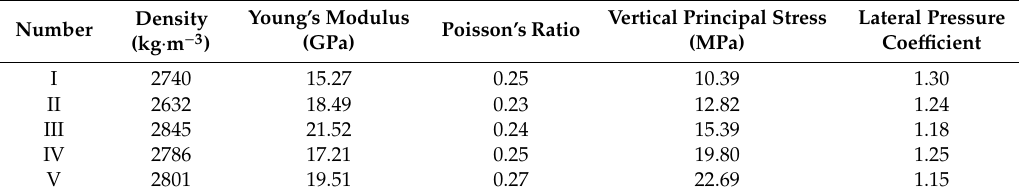
Table 3. Rock mass parameters.